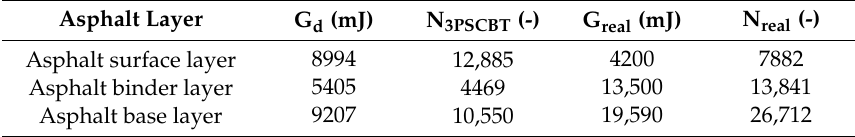
Table 6. Determining the permissible number of load cycles for real pavement